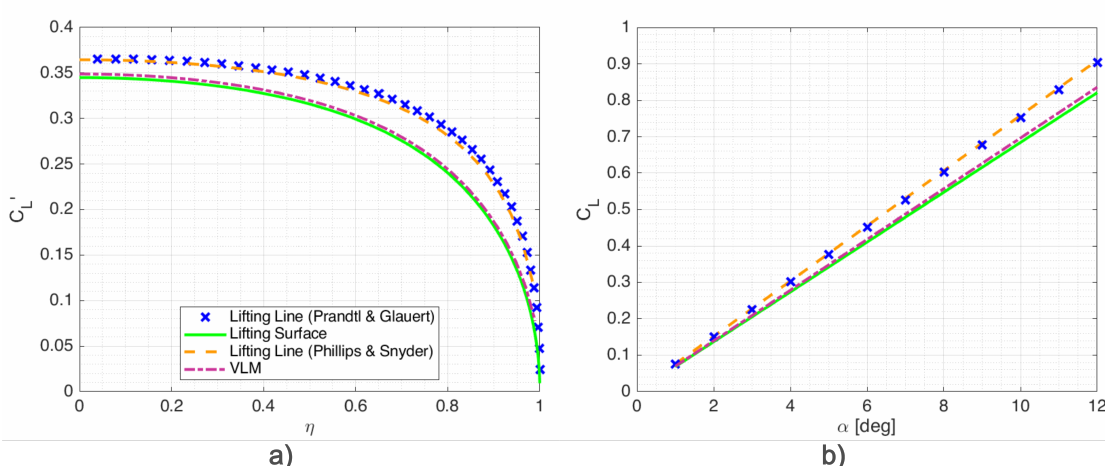
Figure A1. ( a ) Lift distribution prediction at α = 4.2 ◦ and ( b ) lift curve slope for AR5 straight wing. All methods considered predict the shape of the lift distribution well, however both lifting surface and VLM predict a slightly lower lift curve